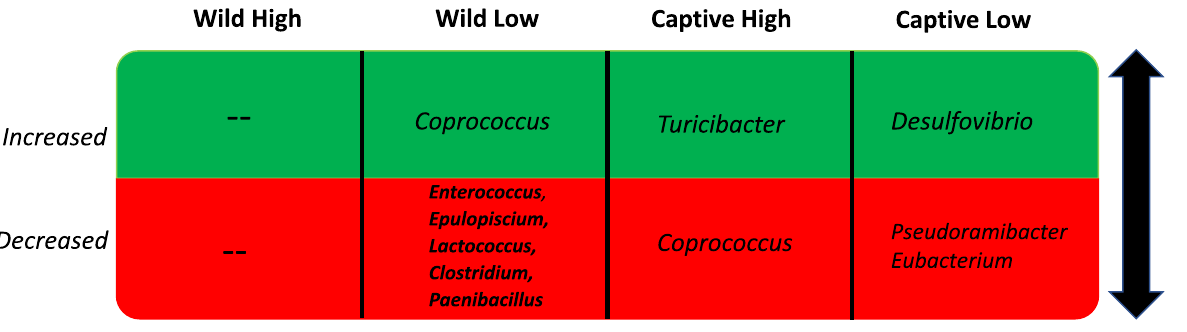
Table 3 Genera that significantly ( p < 0.05, ANOVA , FDR adjusted ) increased (green) or decreased (red) within each treatment group between week 1 and week 6 post FMT. Wild High had no change in bacterial